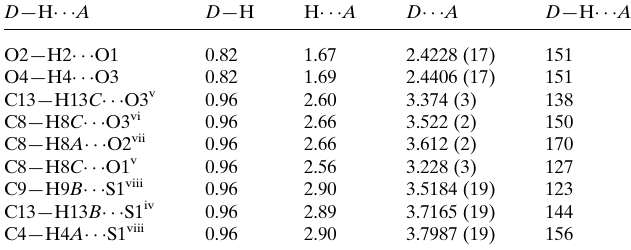
Symmetry codes: (i) x ; y (cid:2) 1 ; z ; (ii) (cid:2) x þ 1 ; (cid:2) y ; (cid:2) z þ 1; (iii) (cid:2) x þ 1 ; (cid:2) y þ 1 ; (cid:2) z þ 2; (iv) (cid:2) x ; (cid:2) y þ 1 ; (cid:2) z þ 1. Table 2 Hydrogen-bond geometry (A˚ , (cid:3)